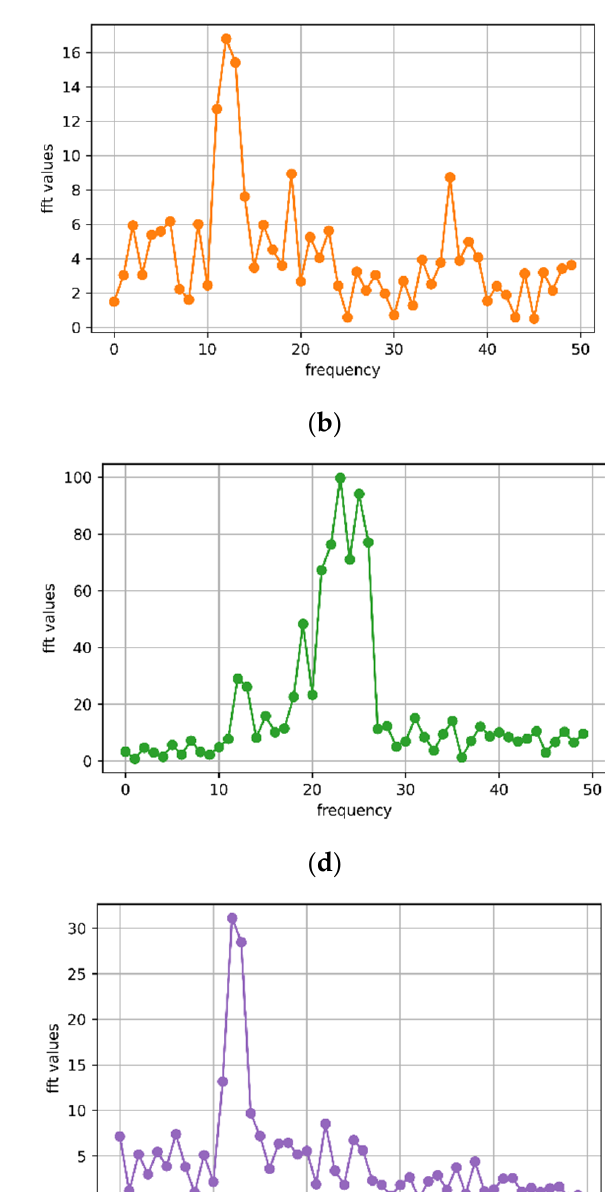
Figure 6. Time series of three-axis accelerometer and three-axis gyroscope signals from a 20 Hz sampling rate for observed behavior of 5 s of running. Acceleration was in g (9.8 m/s 2 ) units.